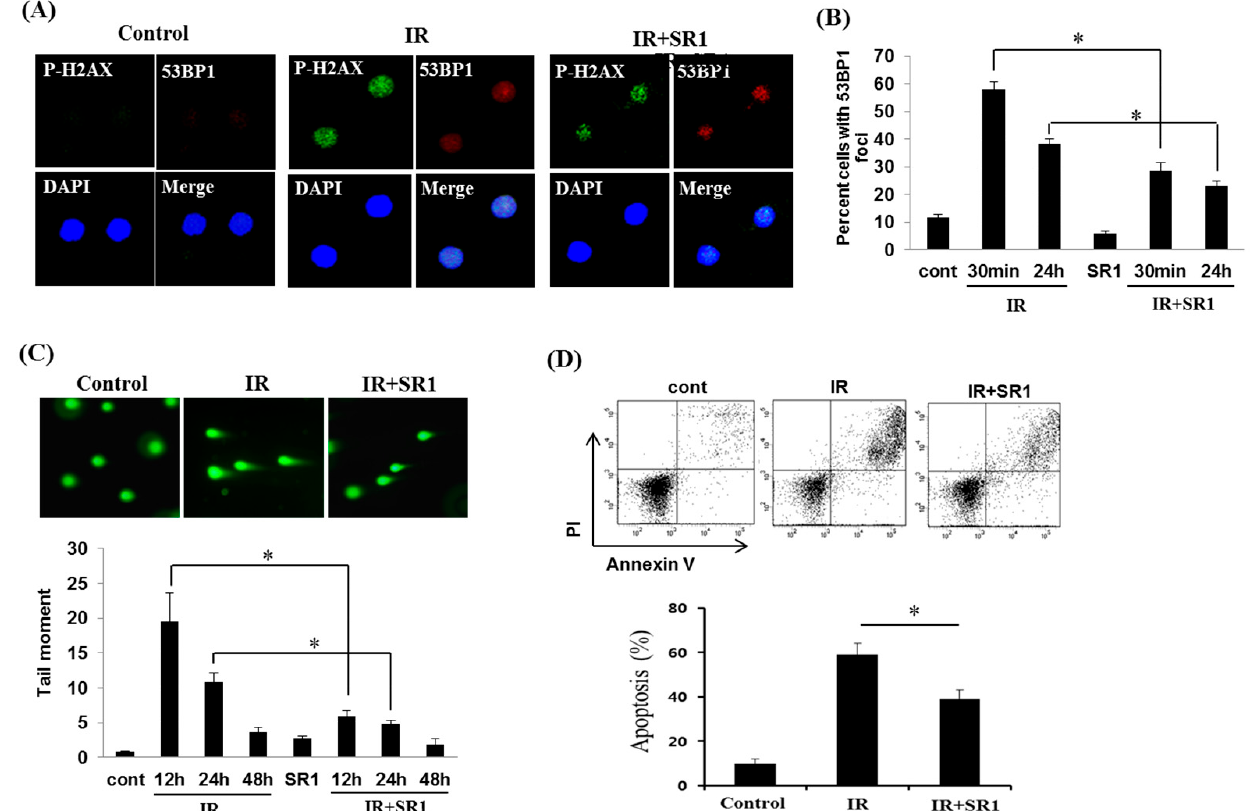
Figure 4. SR1-mediated reduction in genomic instability and apoptosis of HSPCs in response to radiation. ( A ) Immunohistochemical analysis of γ H2AX and 53BP1 in HSPCs with or without SR1 on day 1 after irradiation. Scale bars, 50 µm. ( B ) The quantification of percent cells with 53BP1 foci in HSPCs with or without SR1 at indicated times after irradiation. ( C ) Comet assay representing DNA damage (upper panel) and quantification of DNA damage by tail moment in HSPCs with or without SR1 at indicated times after irradiation. ( D ) Number of apoptotic cells on day 3 after irra- diation with 2 Gy were measured by annexin V staining using FACS analysis. The data are shown as means ± SDs of triplicate experiments (* p < 0.05, two-tailed Student’s t -test).